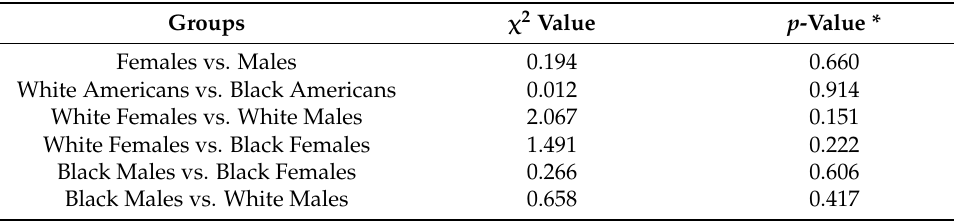
Figure 5. LEH incidence among sub-populations. Table 2. Results of chi-square tests for differences in LEH